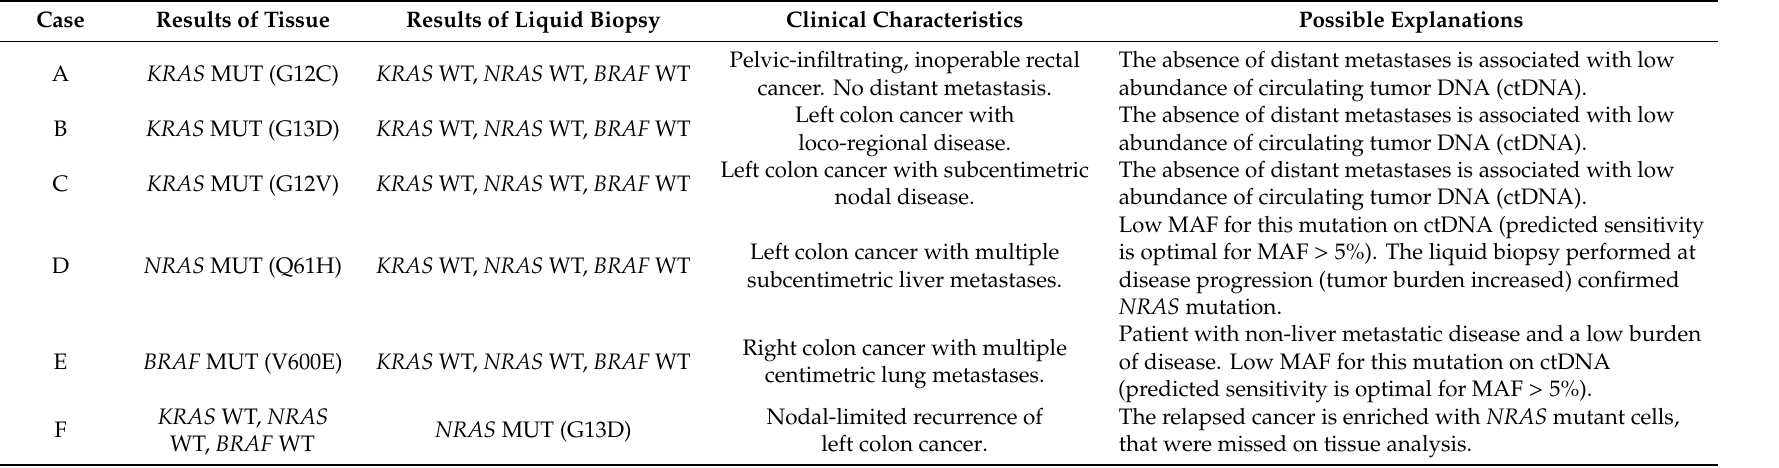
Table 2. Discordant cases in the basal cohort (see text for details). MAF: mutation allele fraction; WT: wild